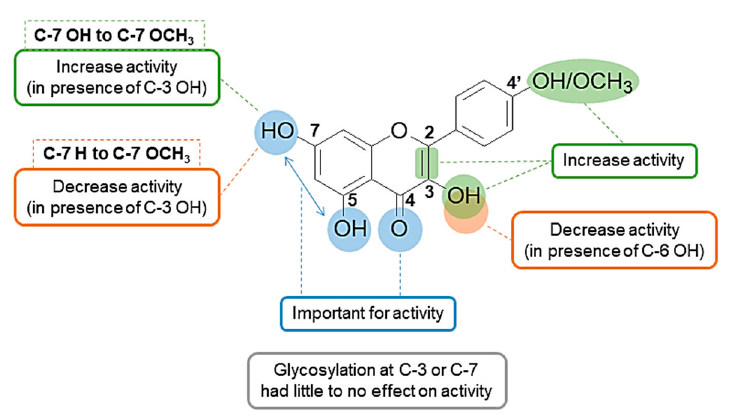
Figure 7. Summary of antiangiogenic SAR of flavonoids.